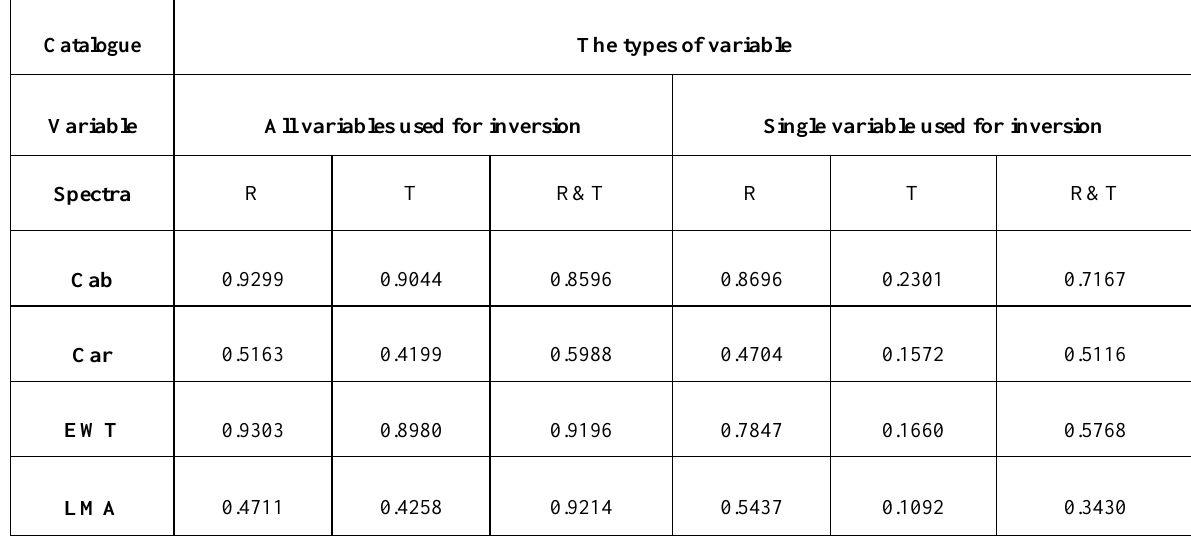
Table 3. Comparison of R 2 values by using all variables and single variables for the inversion model based on the spectra of R, T and R&T. The database is ANGERS and optimal algorithm for cost function is